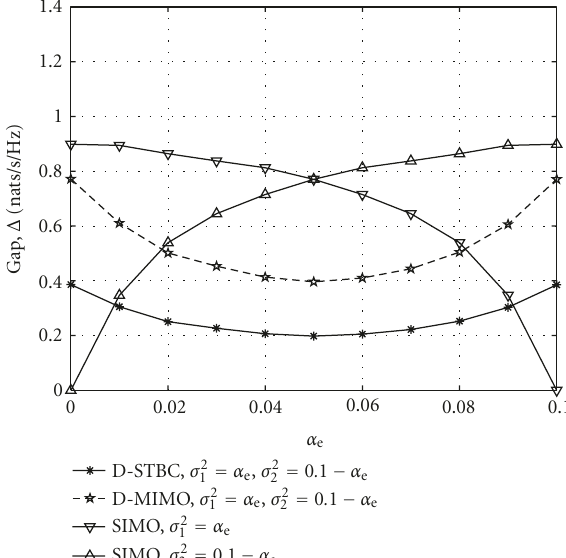
Figure 3: Gap between the mutual information bounds for D- STBCs with two receive antennas, and for its SIMO subchannels at SNR = 20 dB: variations as a function of σ 2 1 = α e given σ 2 1 + σ 2 2 = 0 . 1.